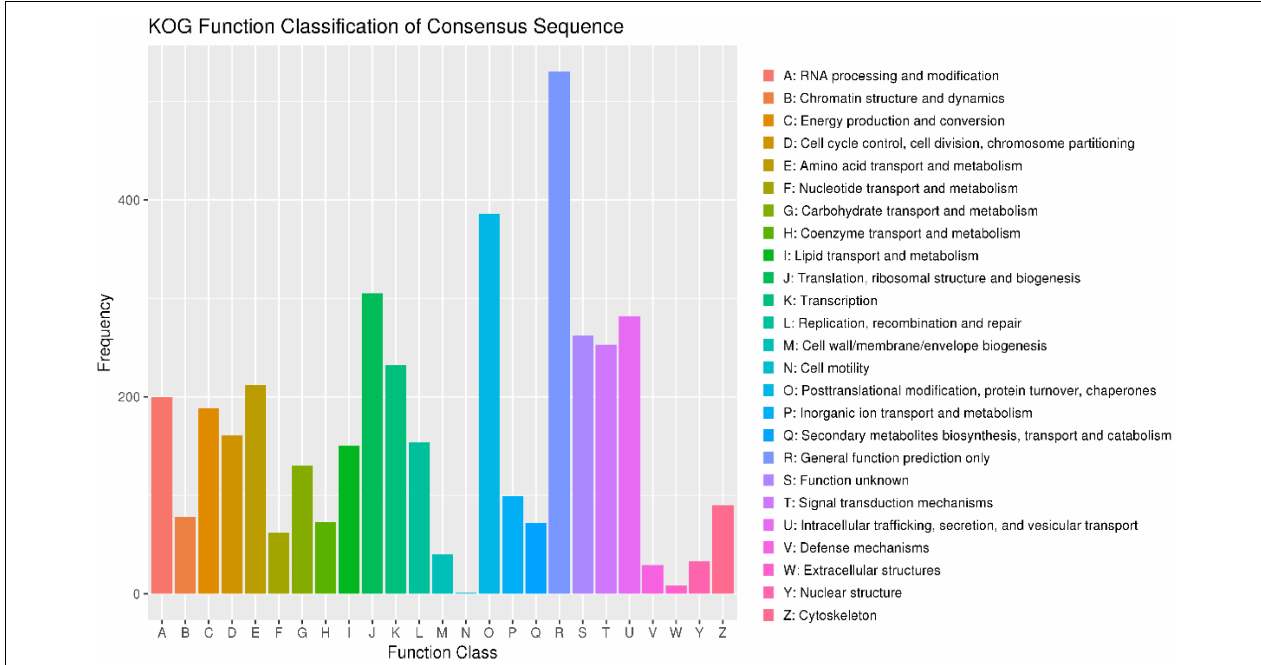
FIGURE 1 | Clusters of orthologous groups of proteins (KOG) function classification of proteins in Metschnikowia bicuspidata LNES0119.